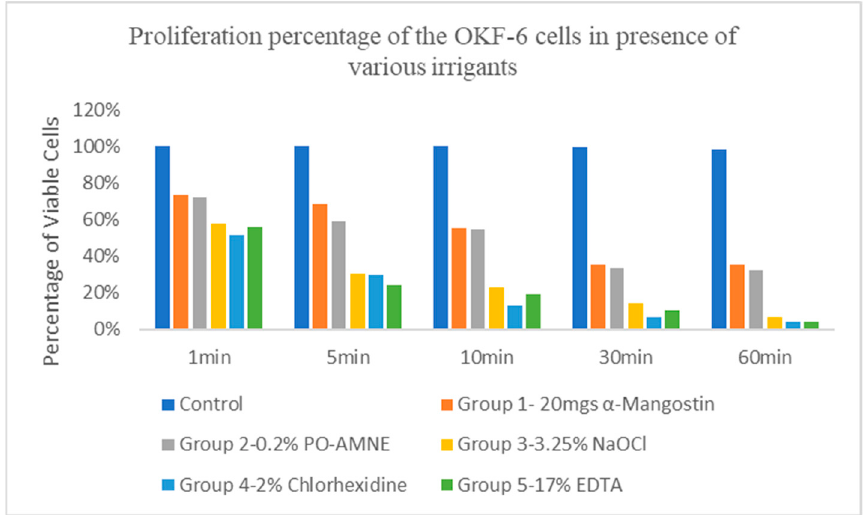
Figure 7. Proliferation percentage of OKF-6 cells in the presence of various